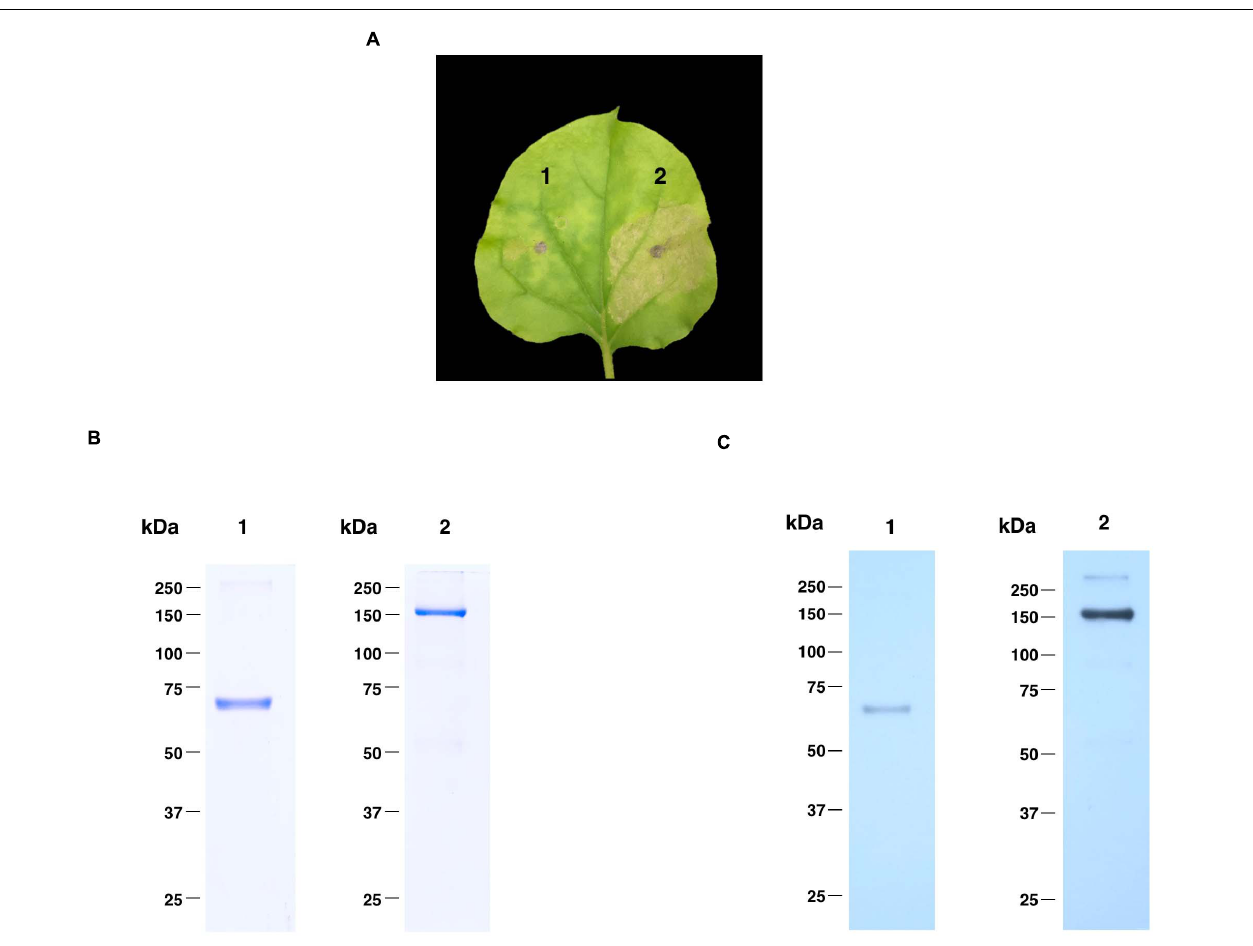
FIGURE 2 | Expression profiles of plant-produced SARS-CoV-2 RBD-Fc fusion protein. Phenotype of leaf infiltrated with Agrobacterium control (1) and Agrobacterium containing pBYR2e-SARS-CoV-2 RBD-Fc (2) after 4 dpi (A) . SDS-PAGE analysis of plant-produced SARS-CoV-2 RBD-Fc fusion protein stained with Coomassie staining (B) and western blot of plant-produced SARS-CoV-2 RBD-Fc fusion protein probed with anti-human gamma-HRP conjugate antibody (C) . Lane 1 and 2, purified plant-produced SARS-CoV-2 RBD-Fc fusion protein under reducing and non-reducing condition,